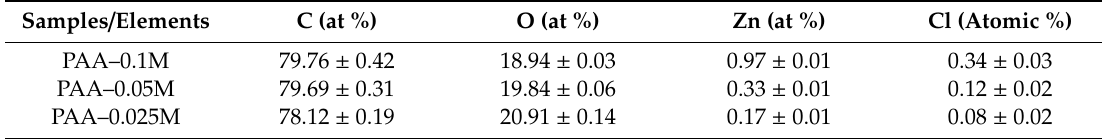
Table 1. The EDS data of the PAA–0.1M, PAA–0.05M and PAA–0.025M surfaces. Samples /